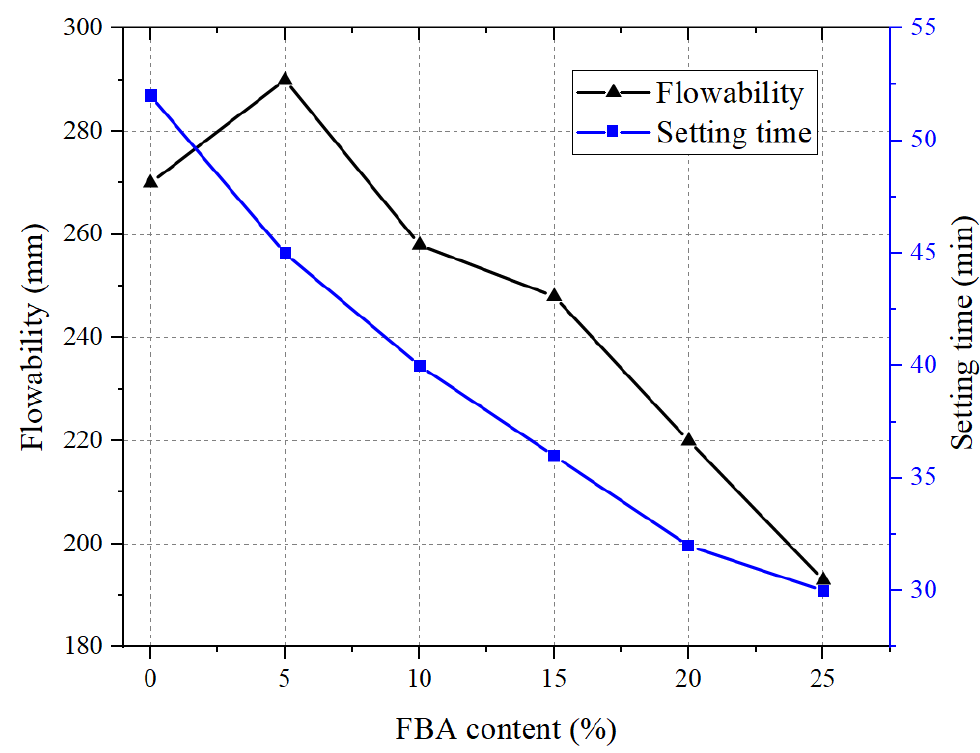
Figure 4. The effect of FBA content on the flowability and setting time of MPC mortars.